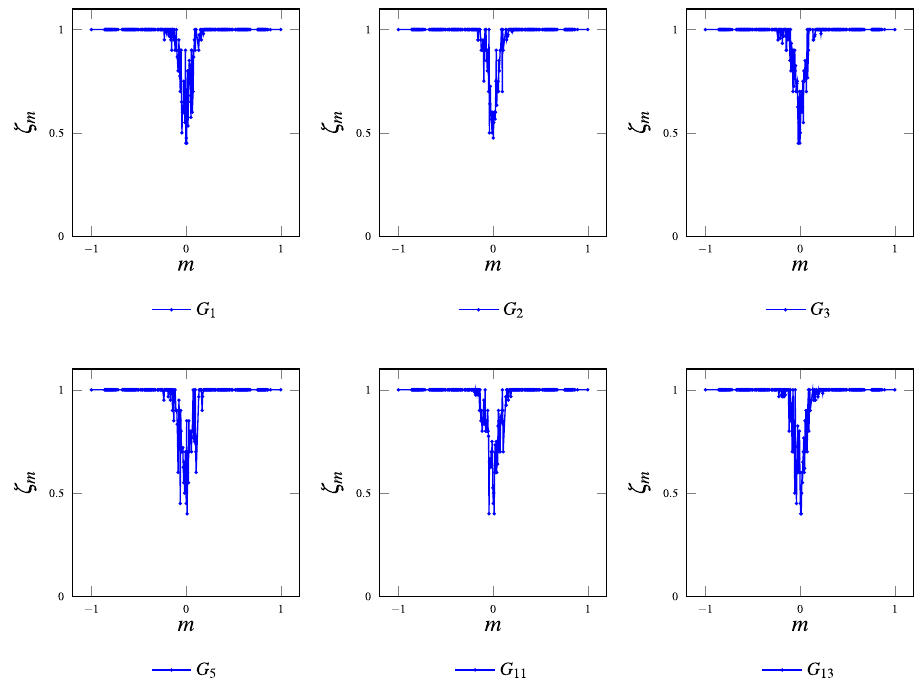
Figure 11. Classification efficacy: grids G 1 , G 2 , G 3 , G 5 , G 11 and G 13 ; 21 × 21 toruses, periodic boundary conditions and asynchronous update.